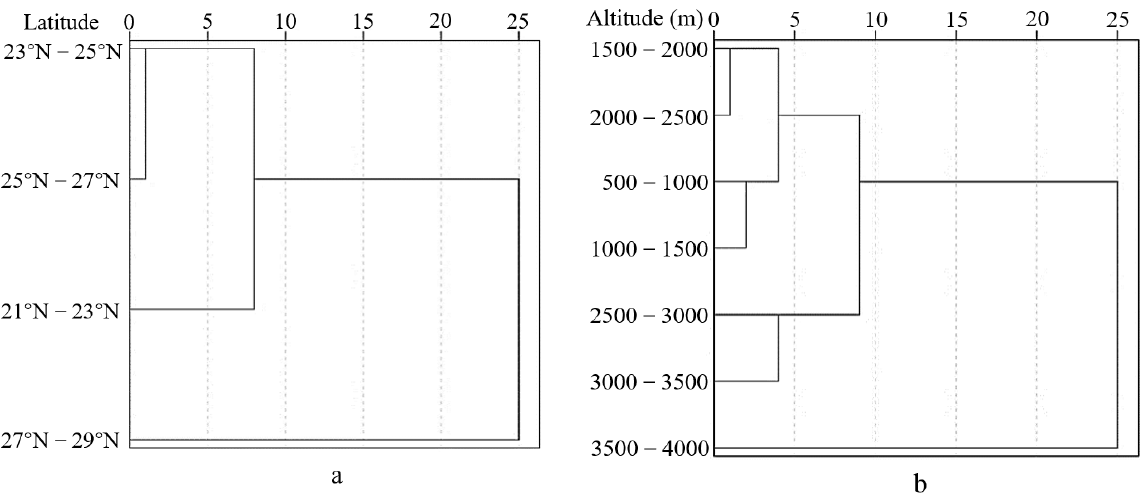
Figure 4. Cluster map of the composition of soil organic matter with latitude ( a ) and altitude ( b ).